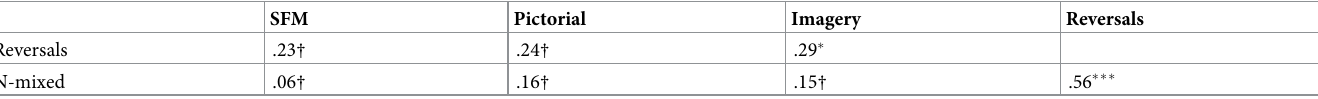
Table 4. Correlations Tau-b, between priming (SFM, pictorial, and imagery), reversals, and mixed